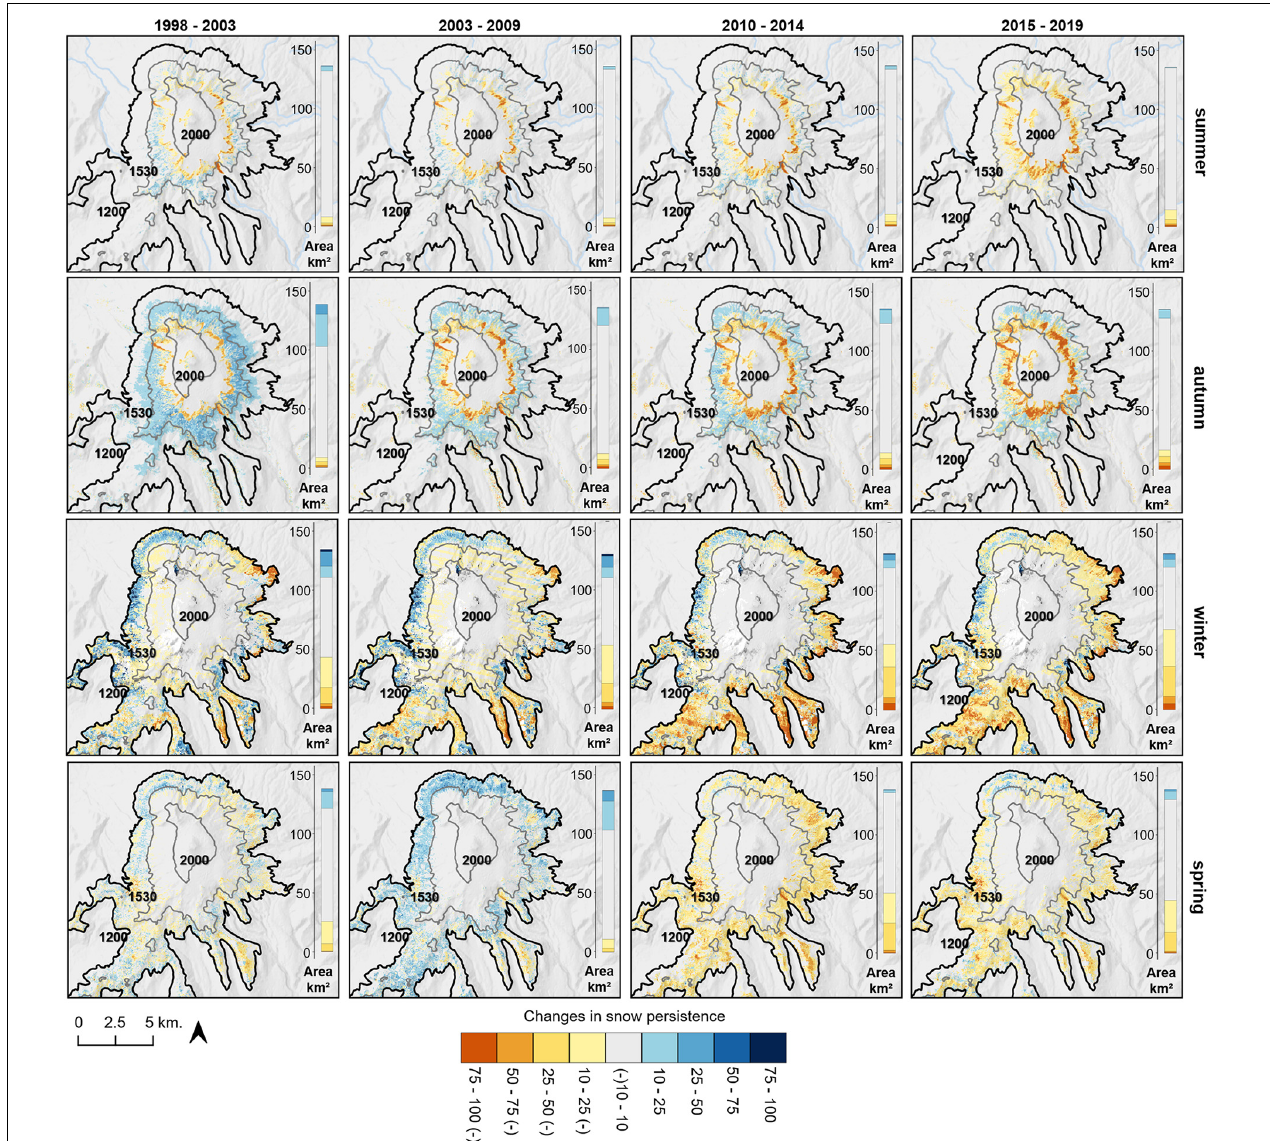
FIGURE 6 | Changes in snow persistence for different periods (columns) and seasons (rows). Reference period (P1: